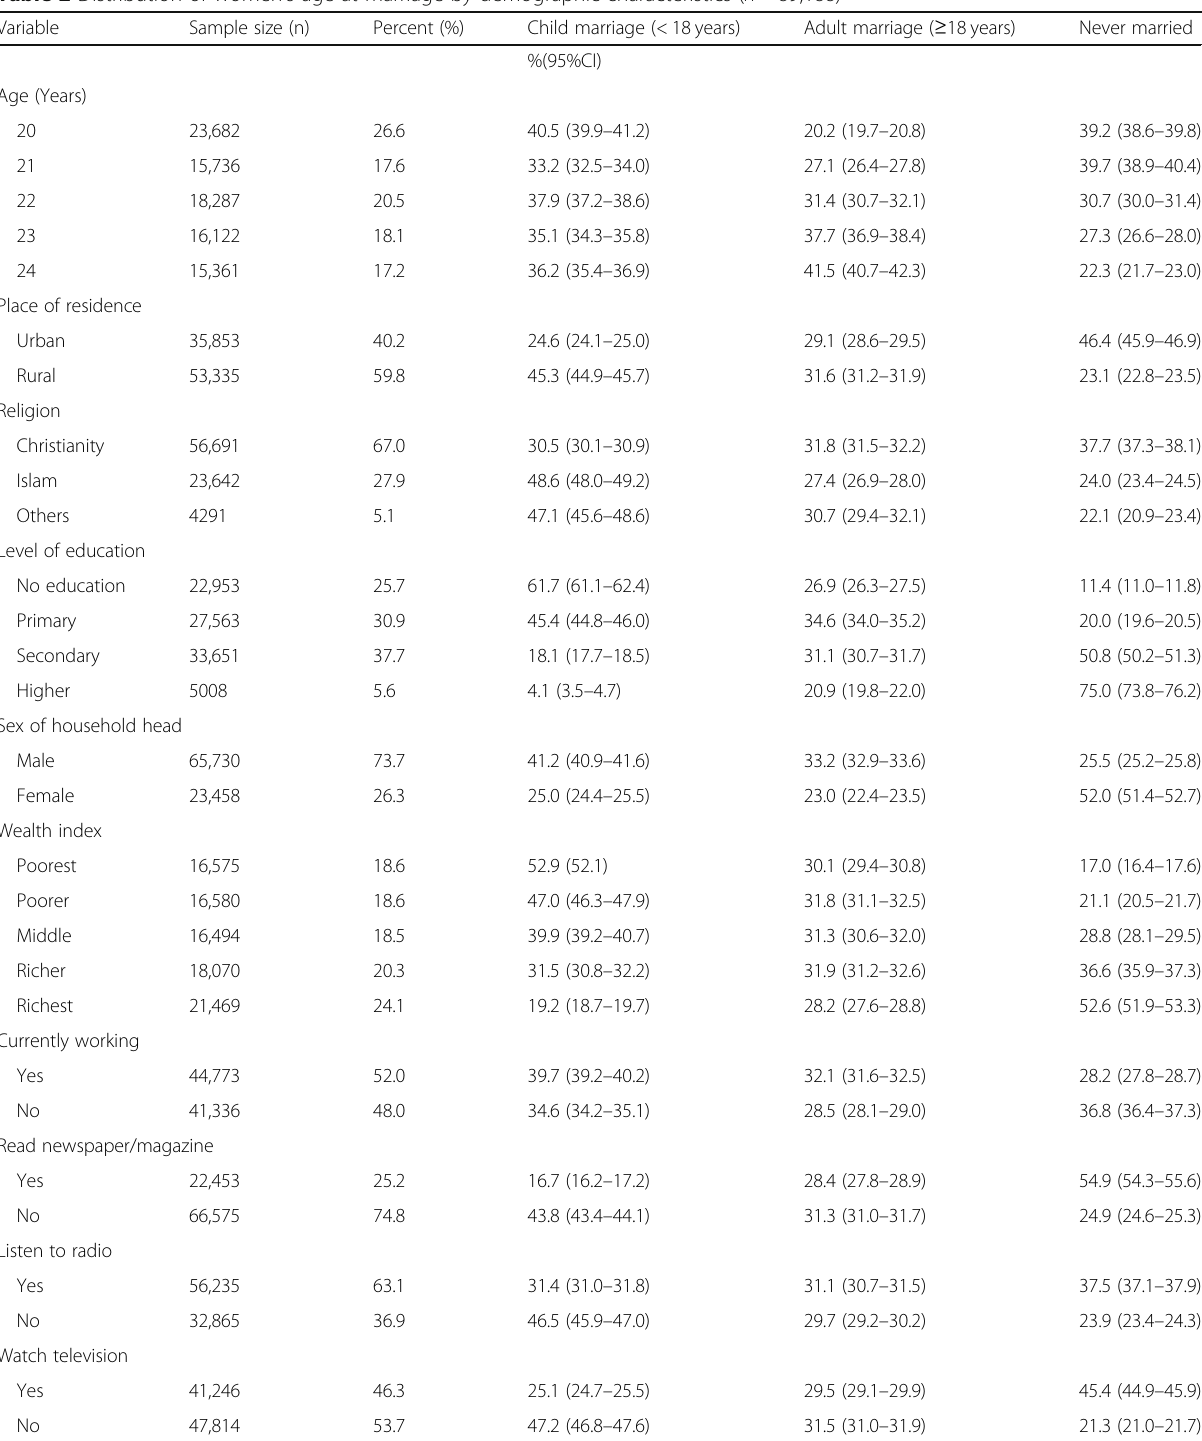
Table 2 Distribution of women ’ s age at marriage by demographic characteristics ( n = 89,188) Variable Sample size